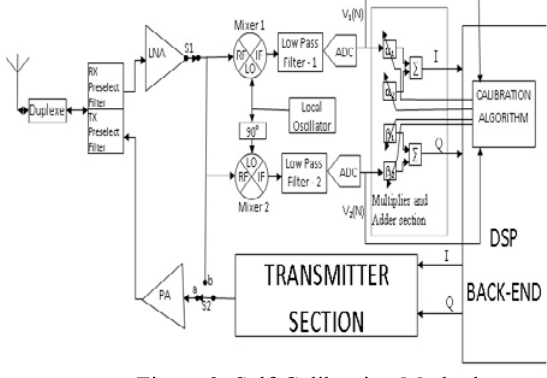
Figure 2: Self-Calibration